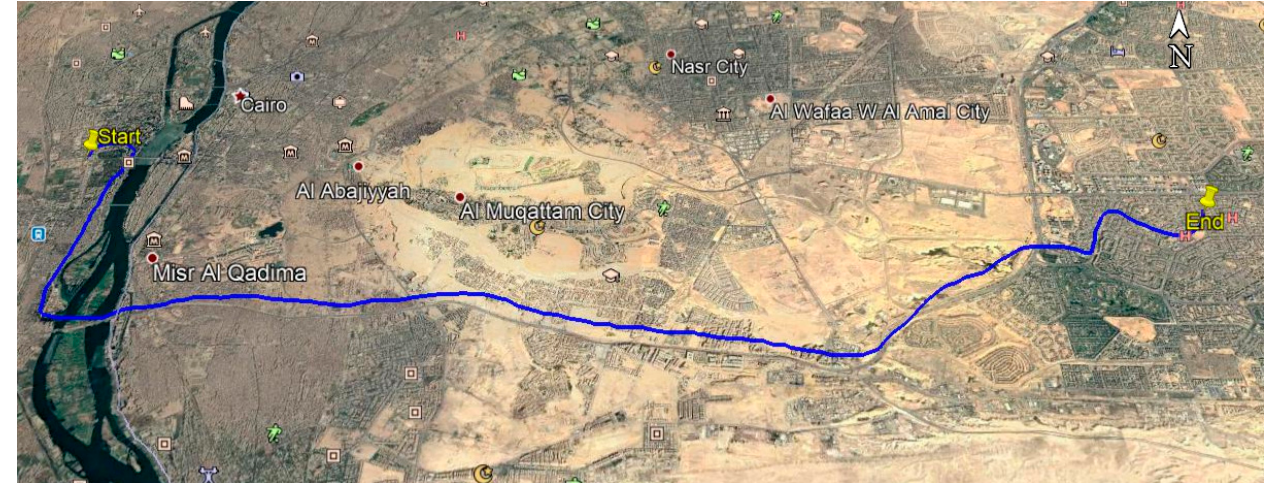
Figure 2. Vehicle trajectory. Figure 2. Positioning errors for stations DLF1 ( left ) and UNB3 ( right ) using different GPS/Galileo PPP models.